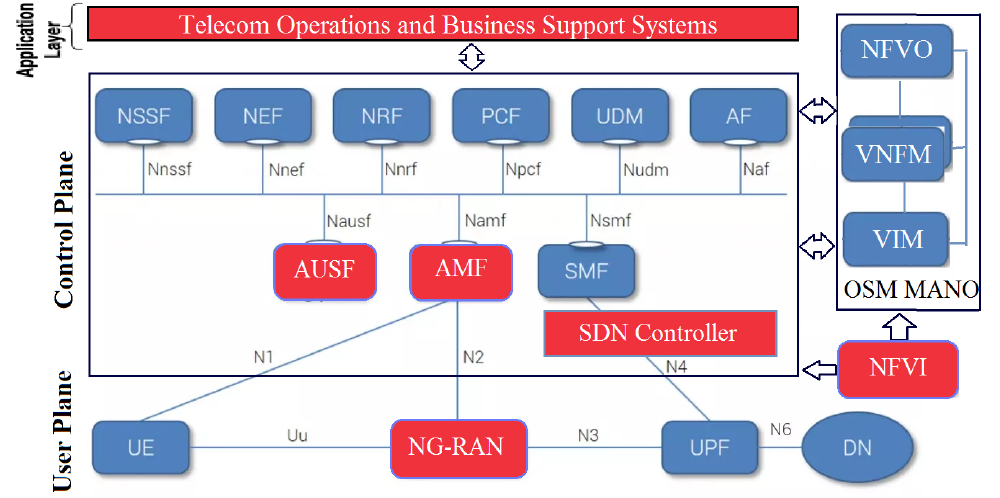
Figure 9. The 5G Edge-based 3GPP planes in our testbed.